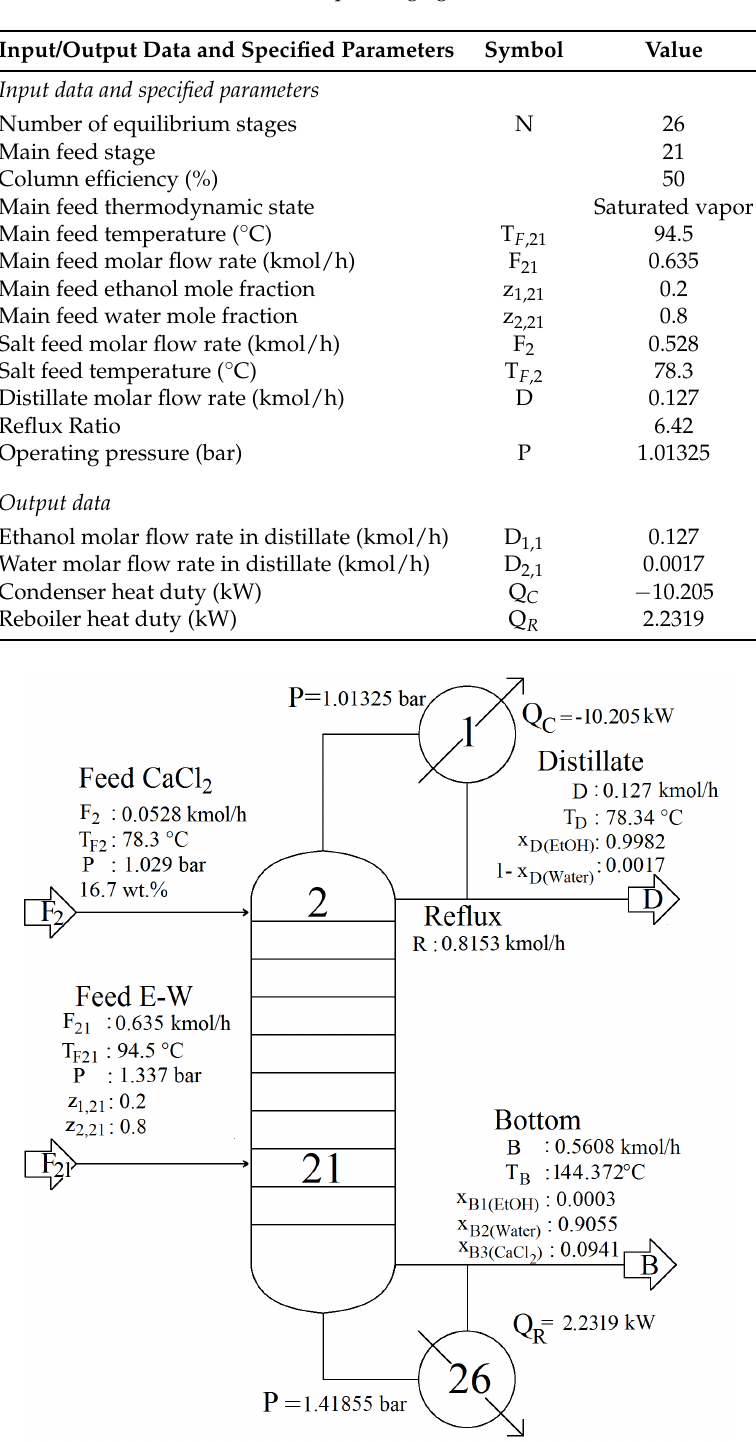
Figure 6. Nominal operating conditions of the salt extractive distillation pilot